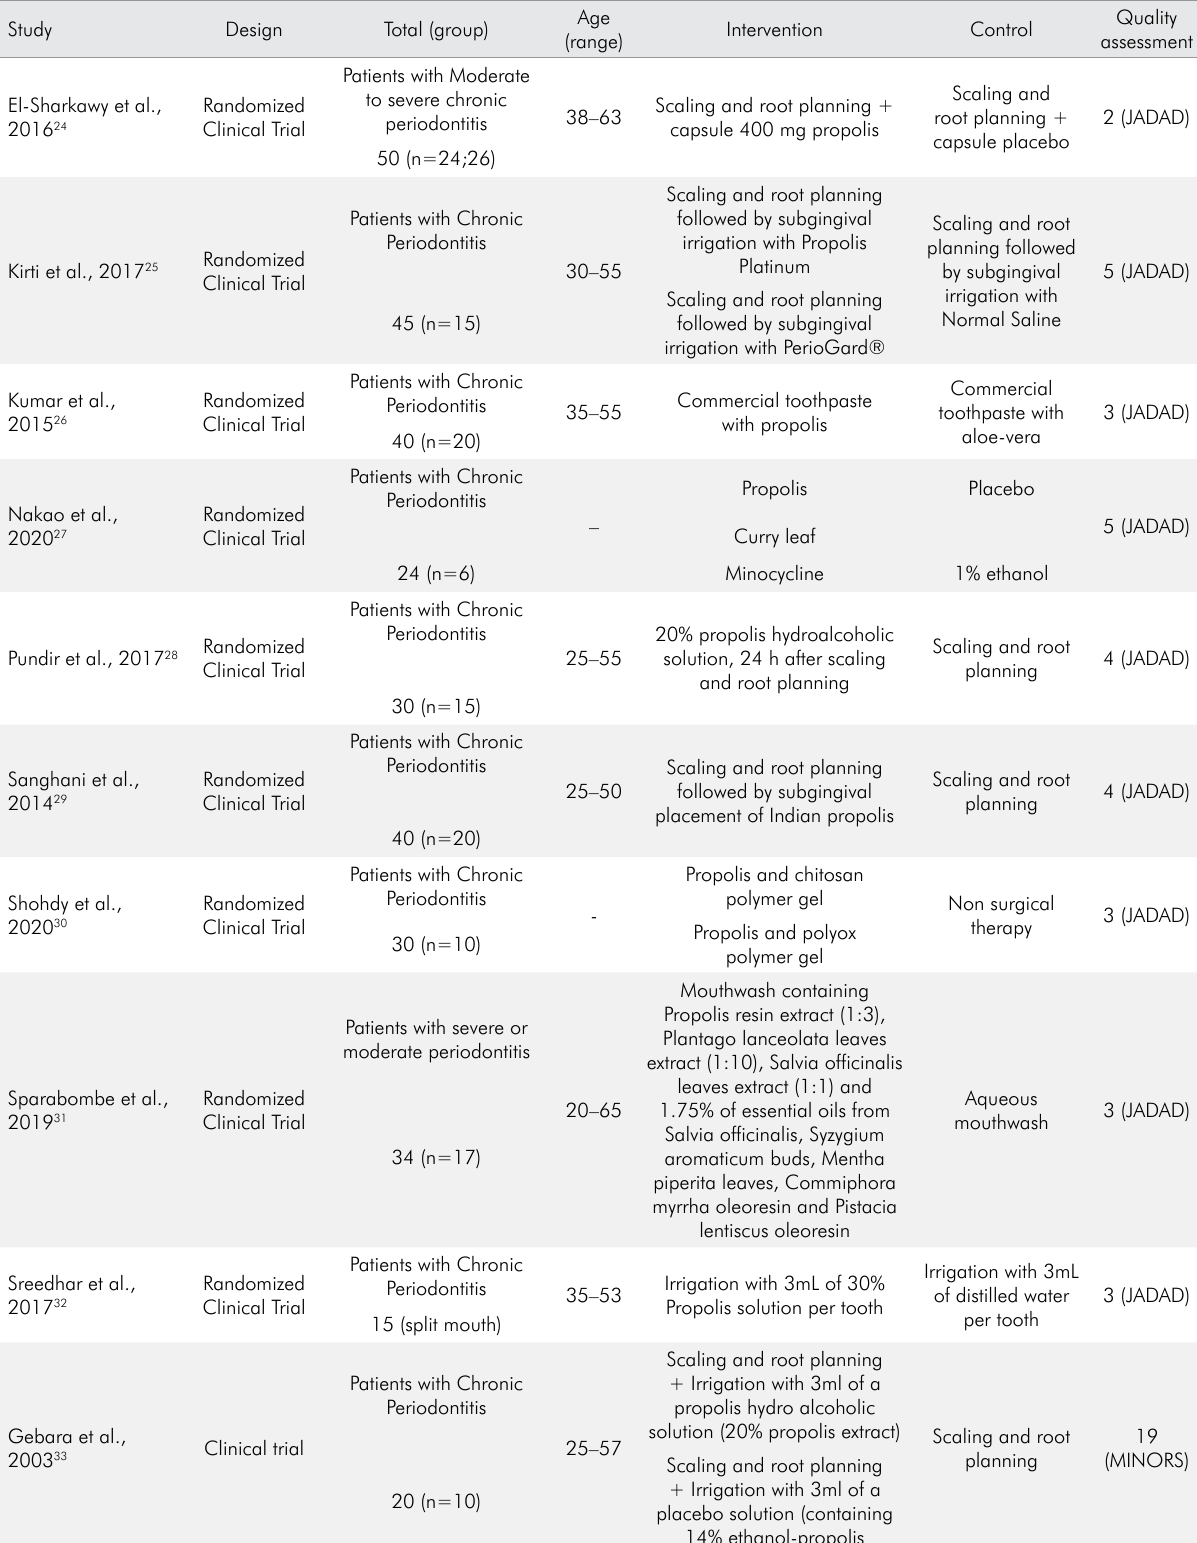
Table 1. Sample and intervention characterization for clinical studies assessing propolis effects in periodontitis